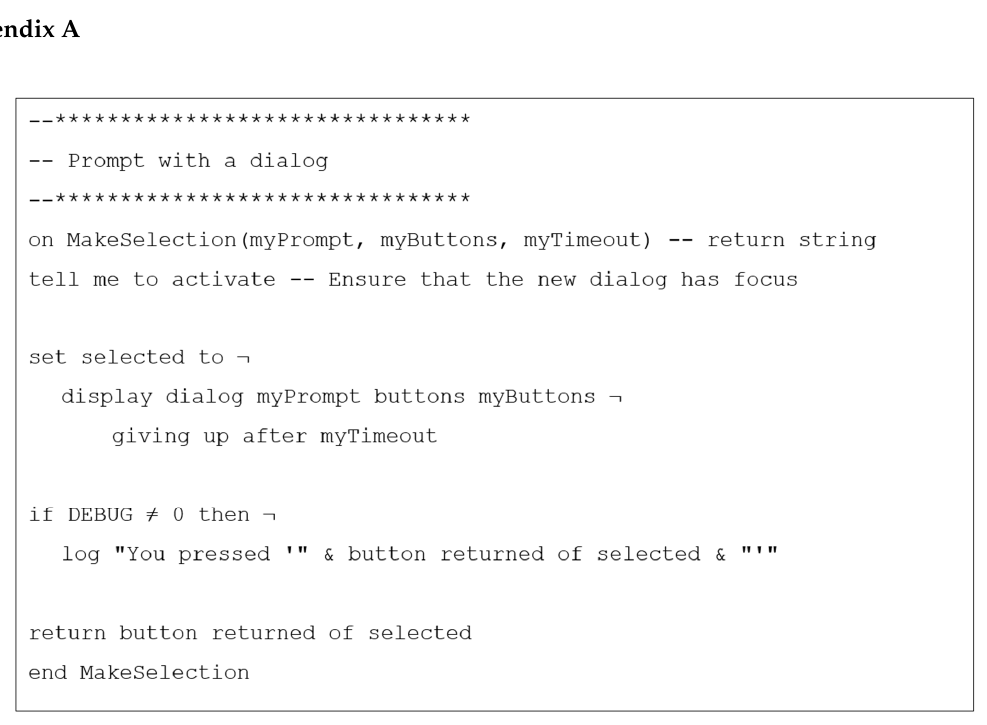
Figure A1. Sample Code Snippet for Dialog Prompt.